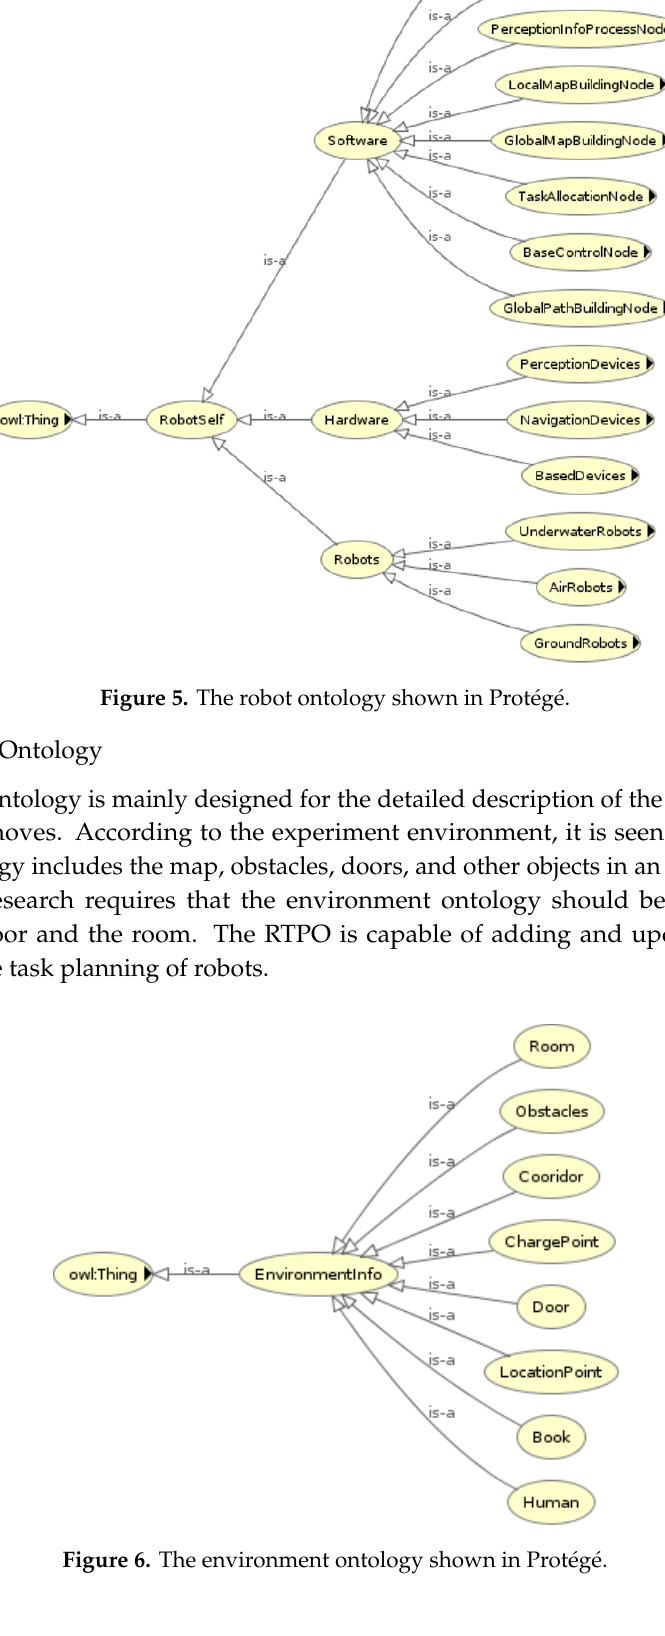
Figure 6. The environment ontology shown in Protégé.